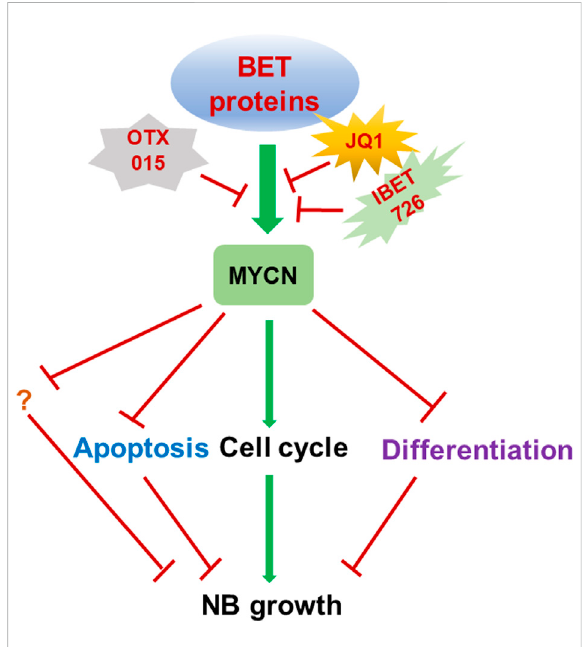
FIGURE 1 Targeting BET proteins inhibits NB growth through